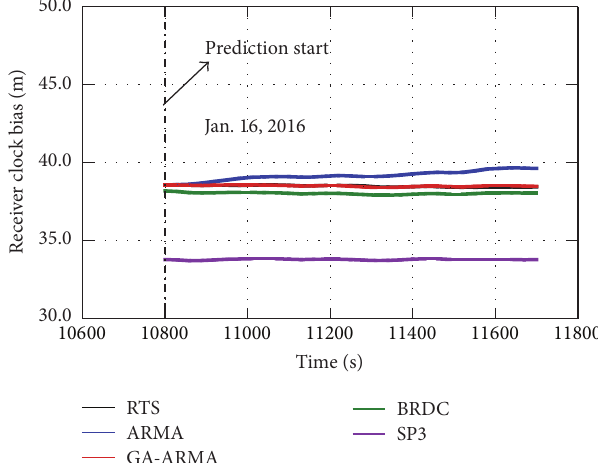
Figure 8: Estimation result of the receiver clock bias (January 16, 2016).